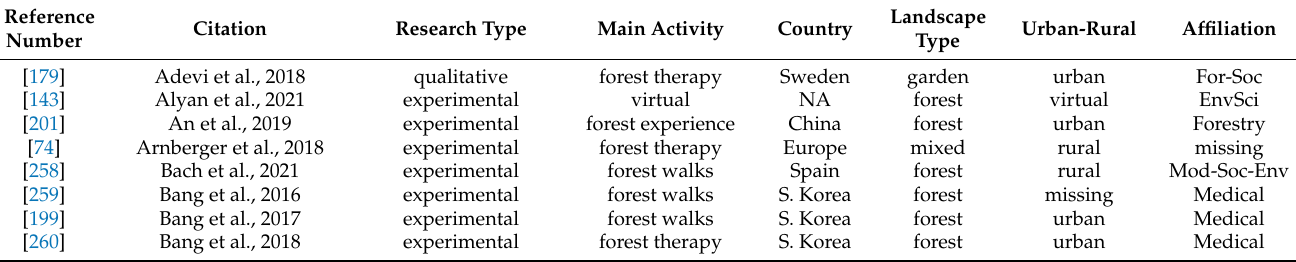
Table A1. Summary characteristics of all articles in review ( n =